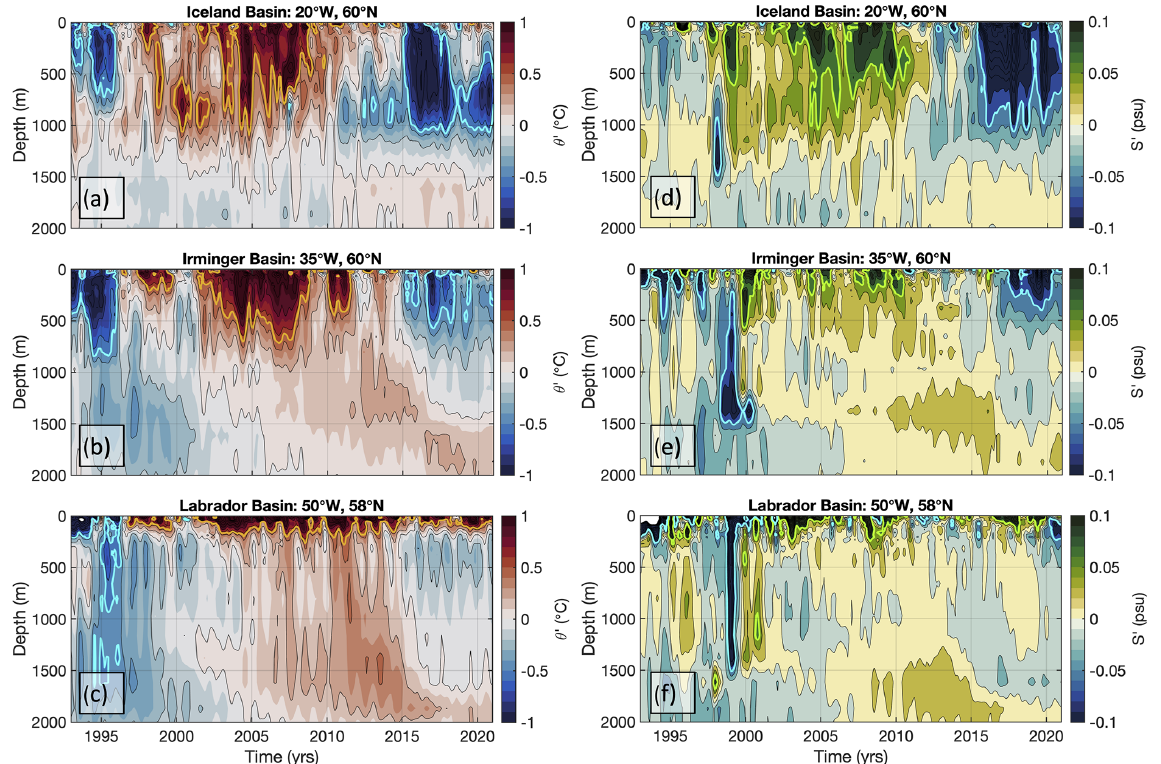
Figure 17. Anomalies of (a–c) potential temperature (with respect to the sea surface) and (d–f) salinity in (a, d) the Iceland Basin (at 20 ◦ W, 60 ◦ N), (b, e) the Irminger Basin (at 35 ◦ W, 60 ◦ N), and (c, f) the Labrador Basin (at 50 ◦ W, 58 ◦ N) (the locations are shown by red stars in Fig. 1). The orange and blue contours in (a–c) show 0.5 and − 0 . 5 ◦ C isotherms, respectively. The green and blue contours in (d–f) show 0.06 and −